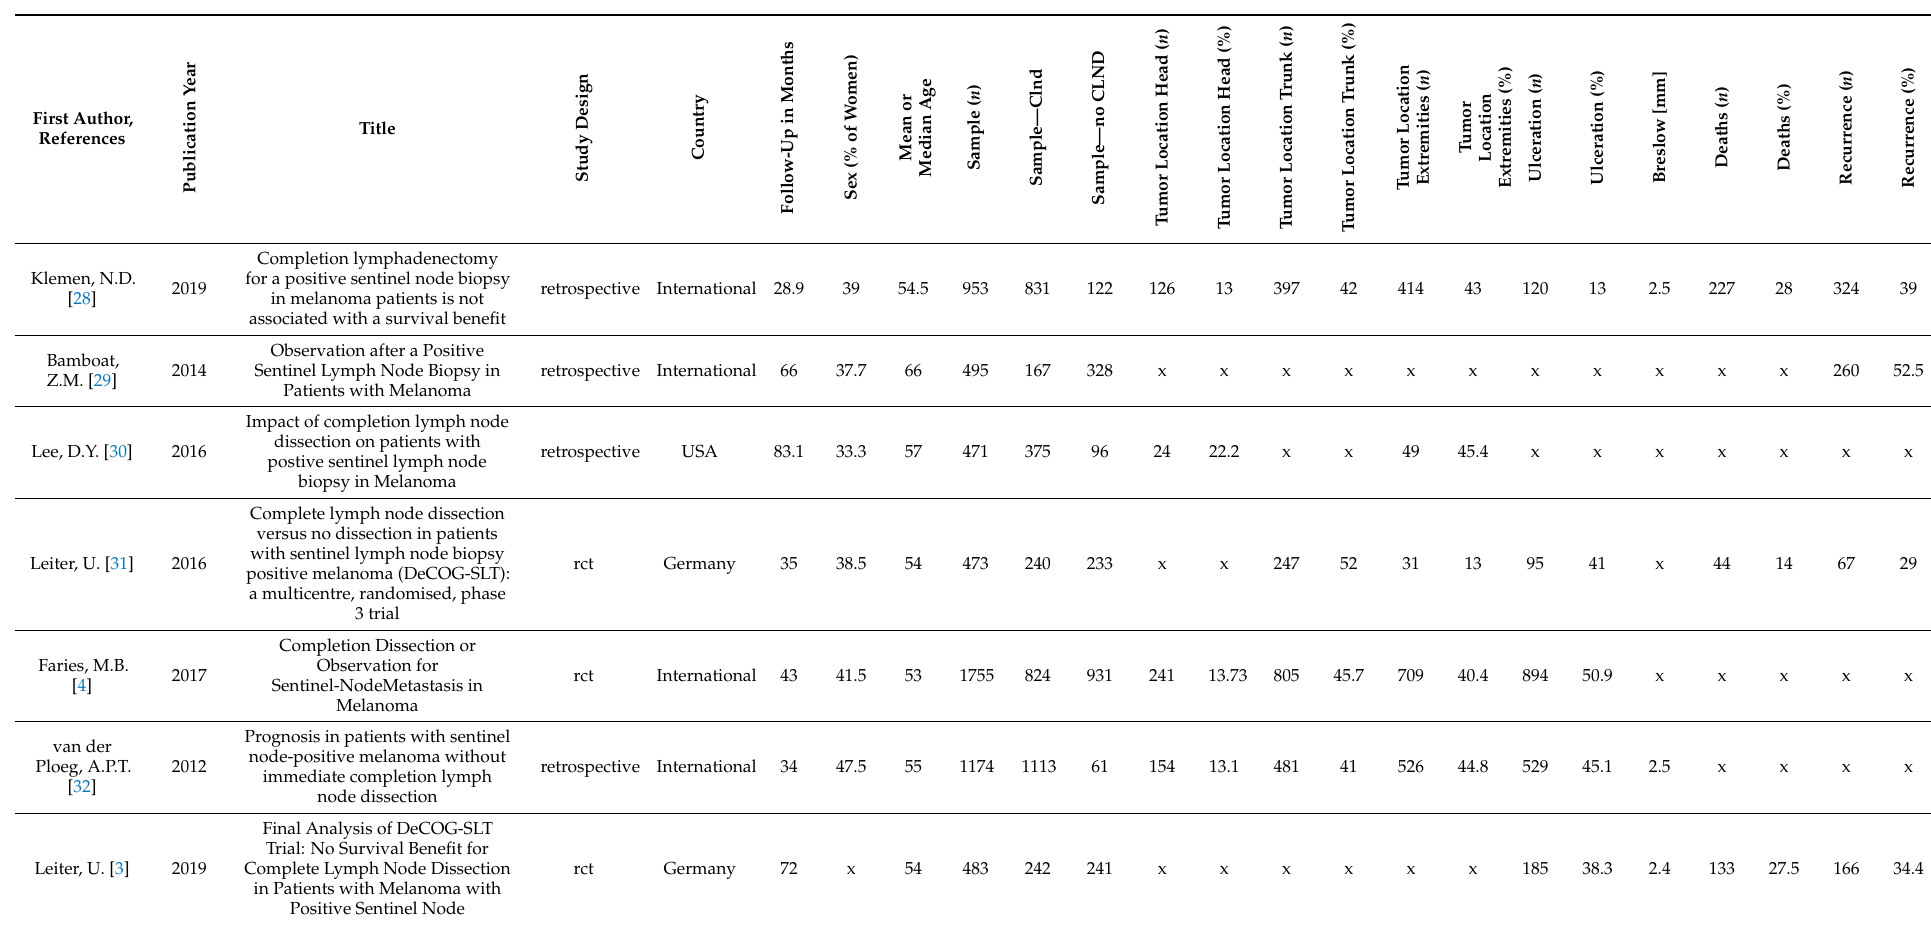
Table 1. Articles included in the